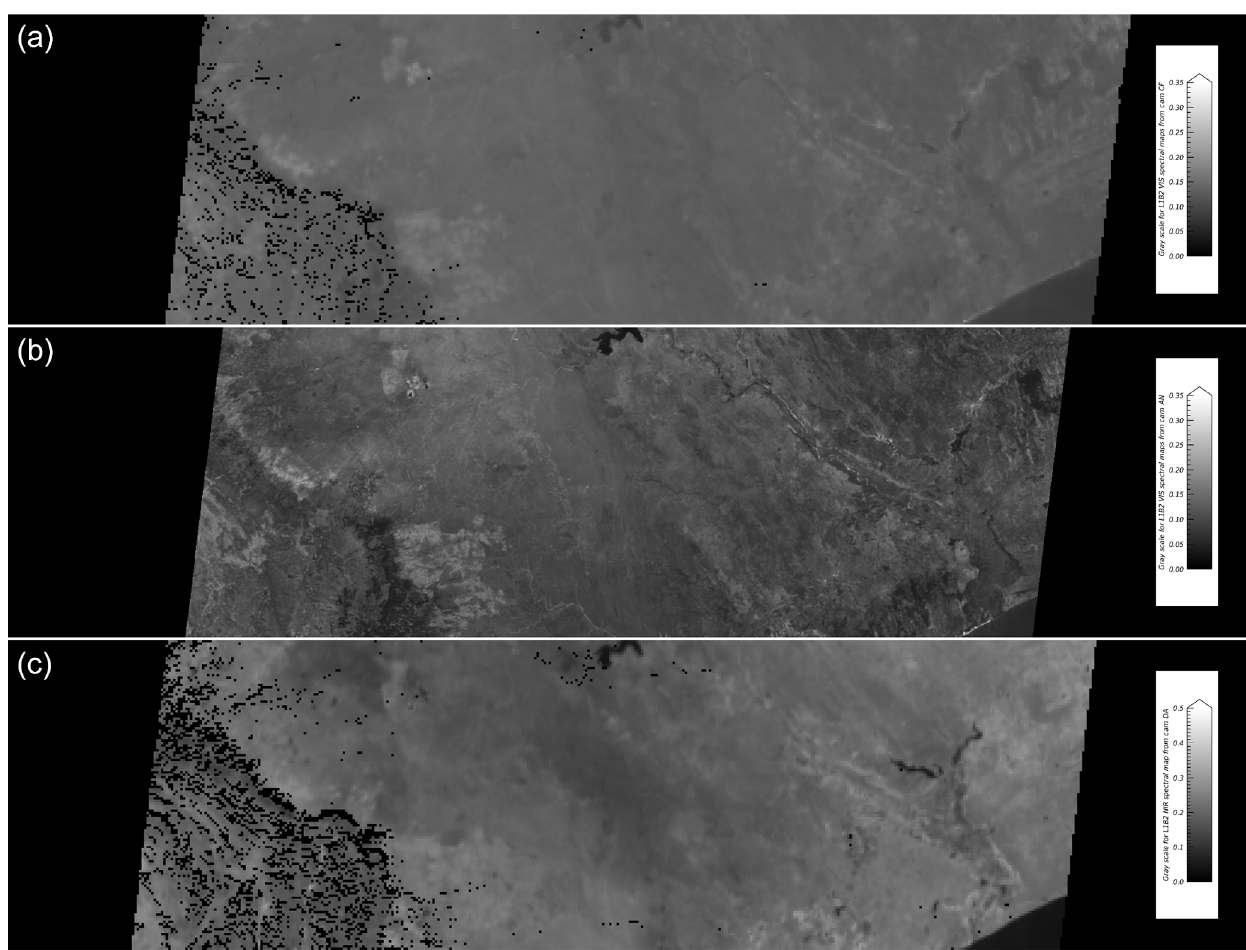
Figure 19. Maps of the MISR L1B2 data channels for the CF/green, AN/red and DA/NIR data channels of P168, O068050 and B110, where artificially inserted missing data have been replaced by best estimates using the algorithm described in this paper. The linear dimensions are the same as in Fig. 1, and gray scale stretching is the same as before: it assigns black to a null reflectance and white to reflectances of 0.35 or more in the blue, green and red spectral bands and 0.50 in the near-infrared spectral